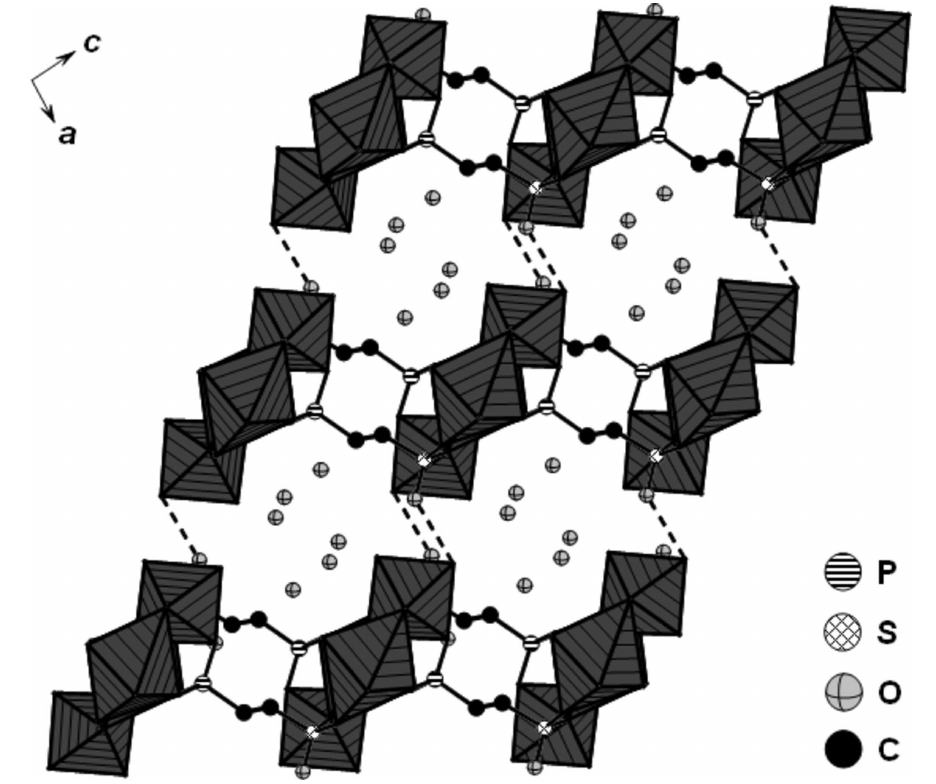
Figure 3 The framework consists of layers, which are connected via hydrogen bonds (dotted line). Poly[[diaqua- µ -hydroxido-( µ -2-phosphonatoethanesulfonato)dicopper(II)] trihydrate] 2 7 Crystal